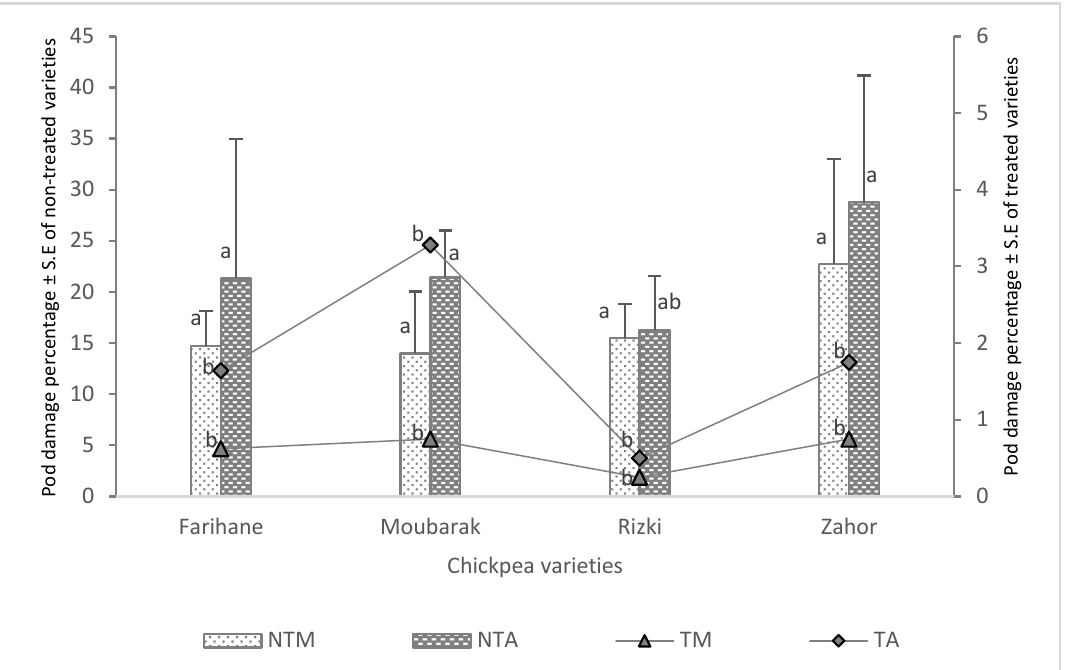
Figure 1. Percentage of pod infestation by chickpea pod borer for all varieties in different locations. NTM: non-treated variety at Marchouch station; NTA: non-treated variety at Allal Tazi station; TM: treated variety at Marchouch station; TA: treated variety at Allal Tazi station; means followed by the same letter(s) do not significantly differ at p <